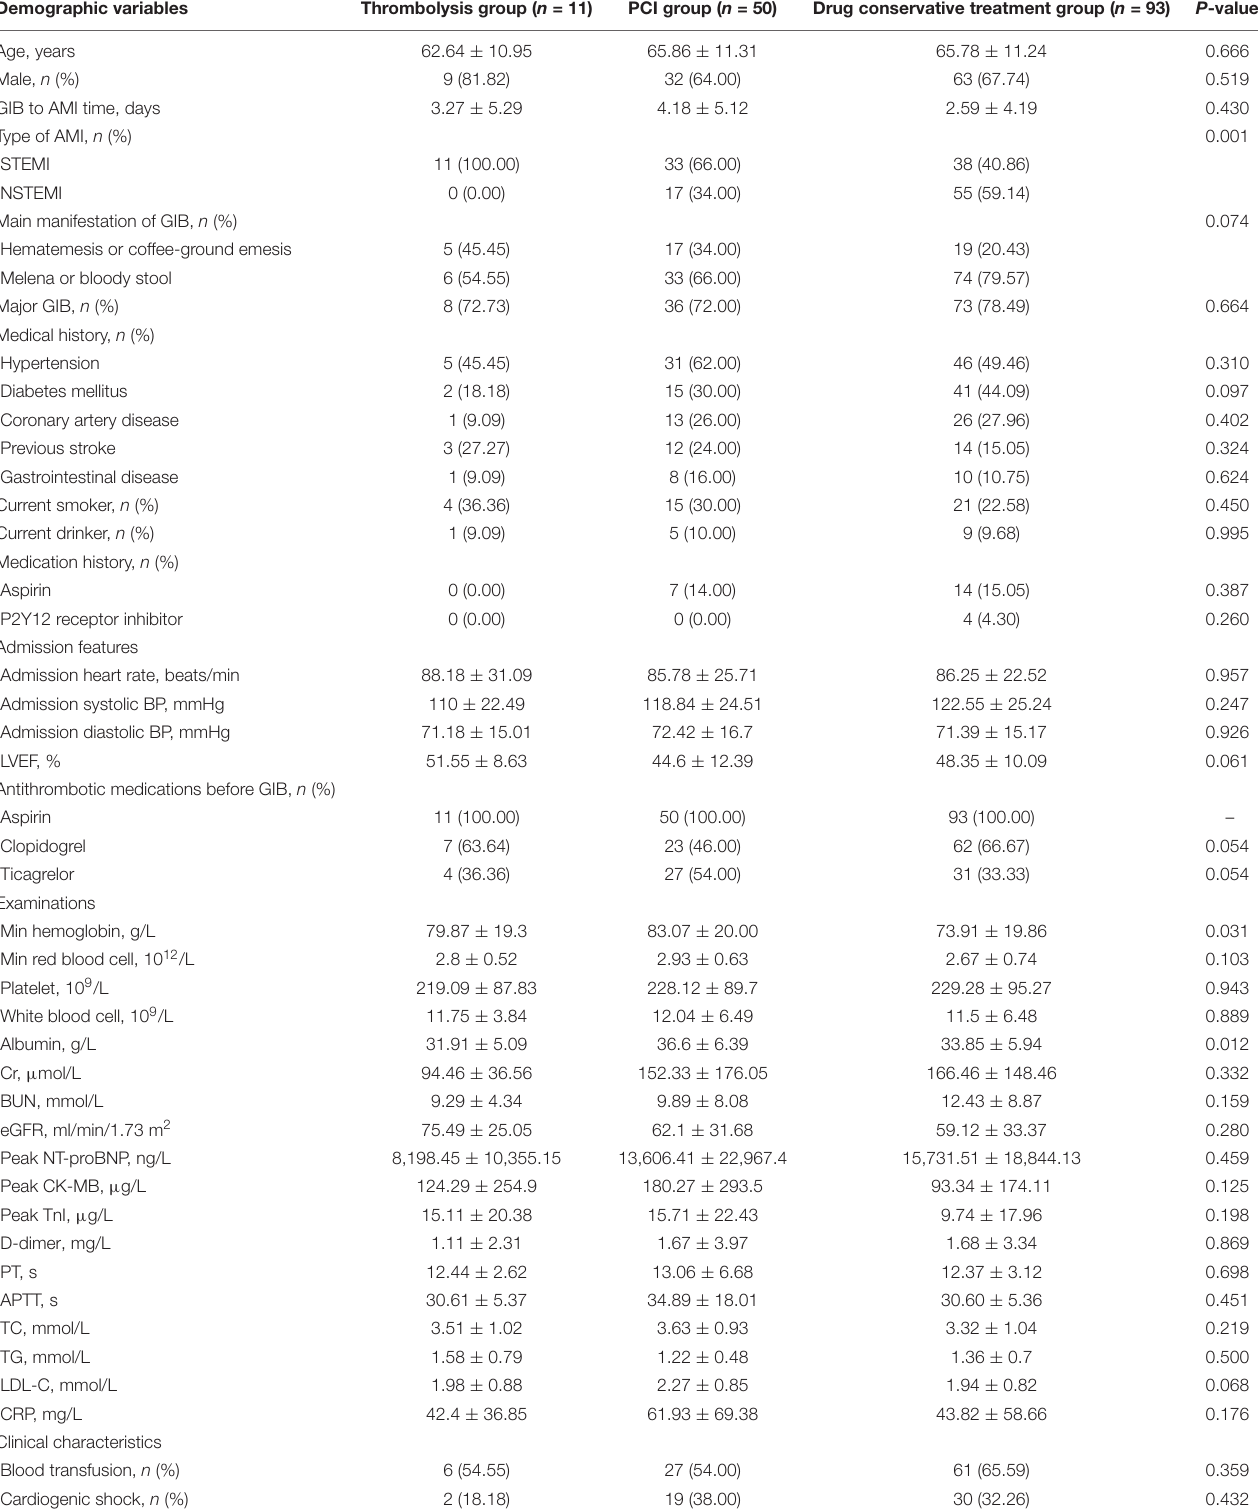
TABLE 1 | Characteristics of patients with GIB post-AMI stratified by different managements of AMI. Demographic